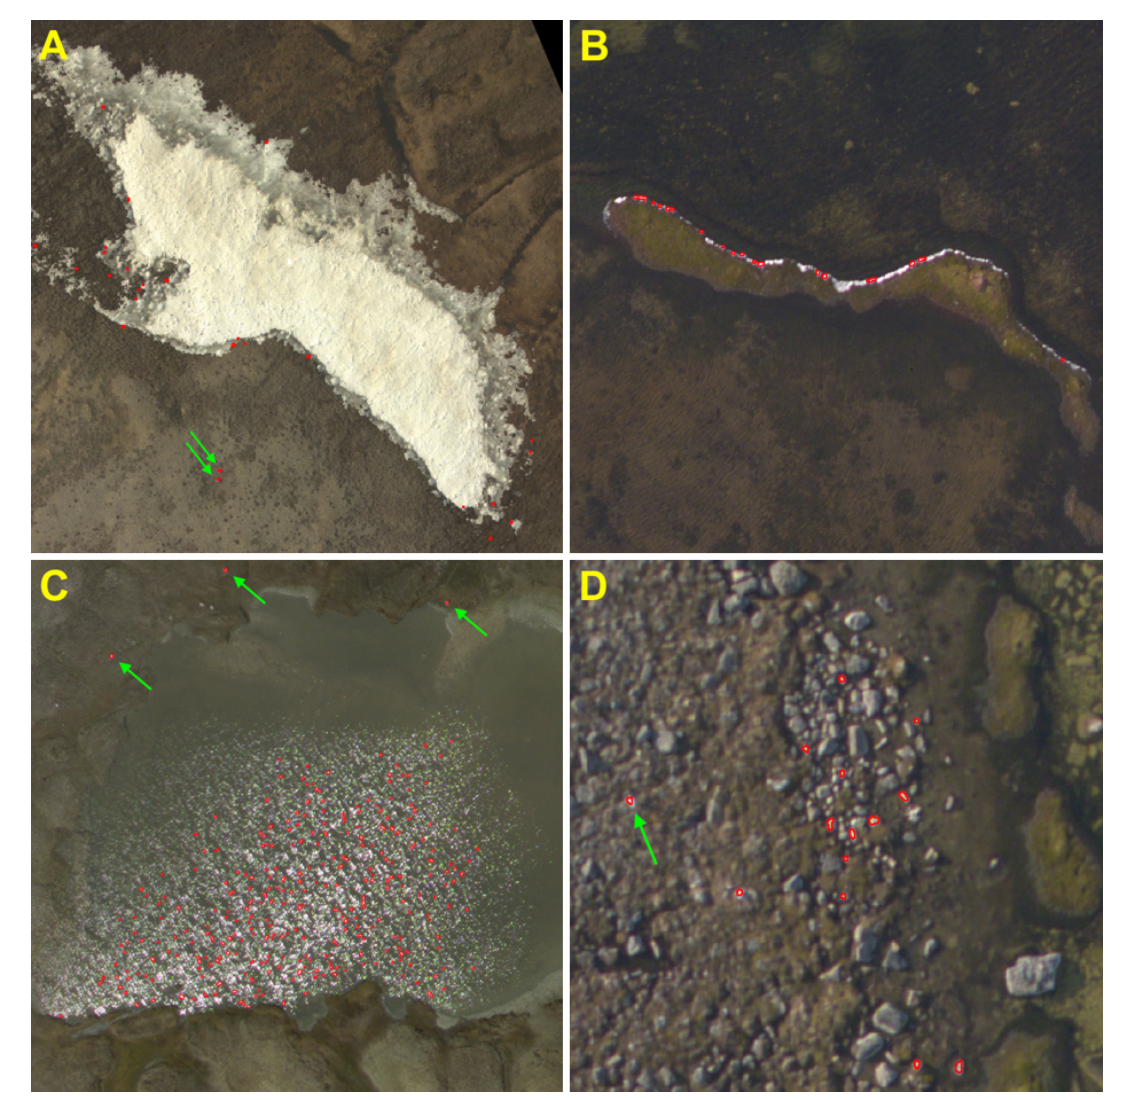
Fig. 9 . Examples of typical commission errors resulting from automated object-based analysis of large volumes of aerial imagery to detect Lesser Snow Geese ( Chen caerulescens caerulescens ) throughout Canadian Arctic breeding colonies: small patches of snow around the periphery of large patches (A), clumps of ice or froth along the edges of water (B), speckles of glint on the surface of water (C), and large bright rocks (D). Objects classified as geese are delineated in red, all of them commission errors except those indicated by green